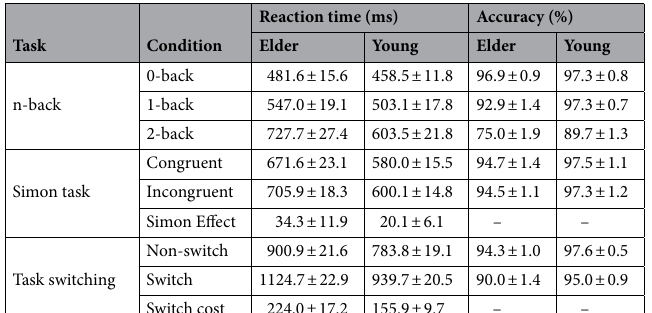
Table 1. Descriptive statistics for executive function tasks. Data are presented as mean ± standard deviation. The Simon effect and switch cost were only calculated by RT.